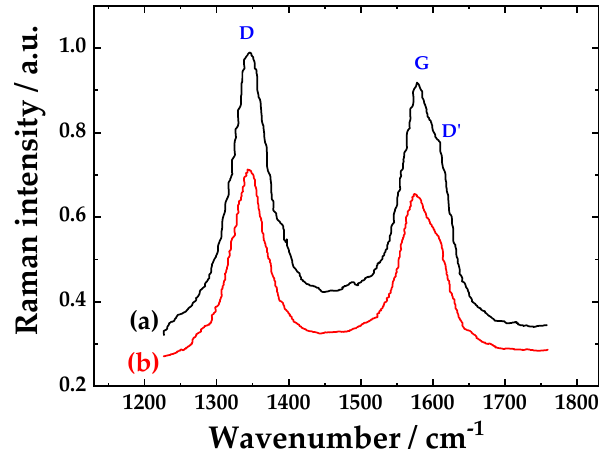
Figure 3. Raman spectra of (a) pristine CNTs and (b) functionalized CNTs.